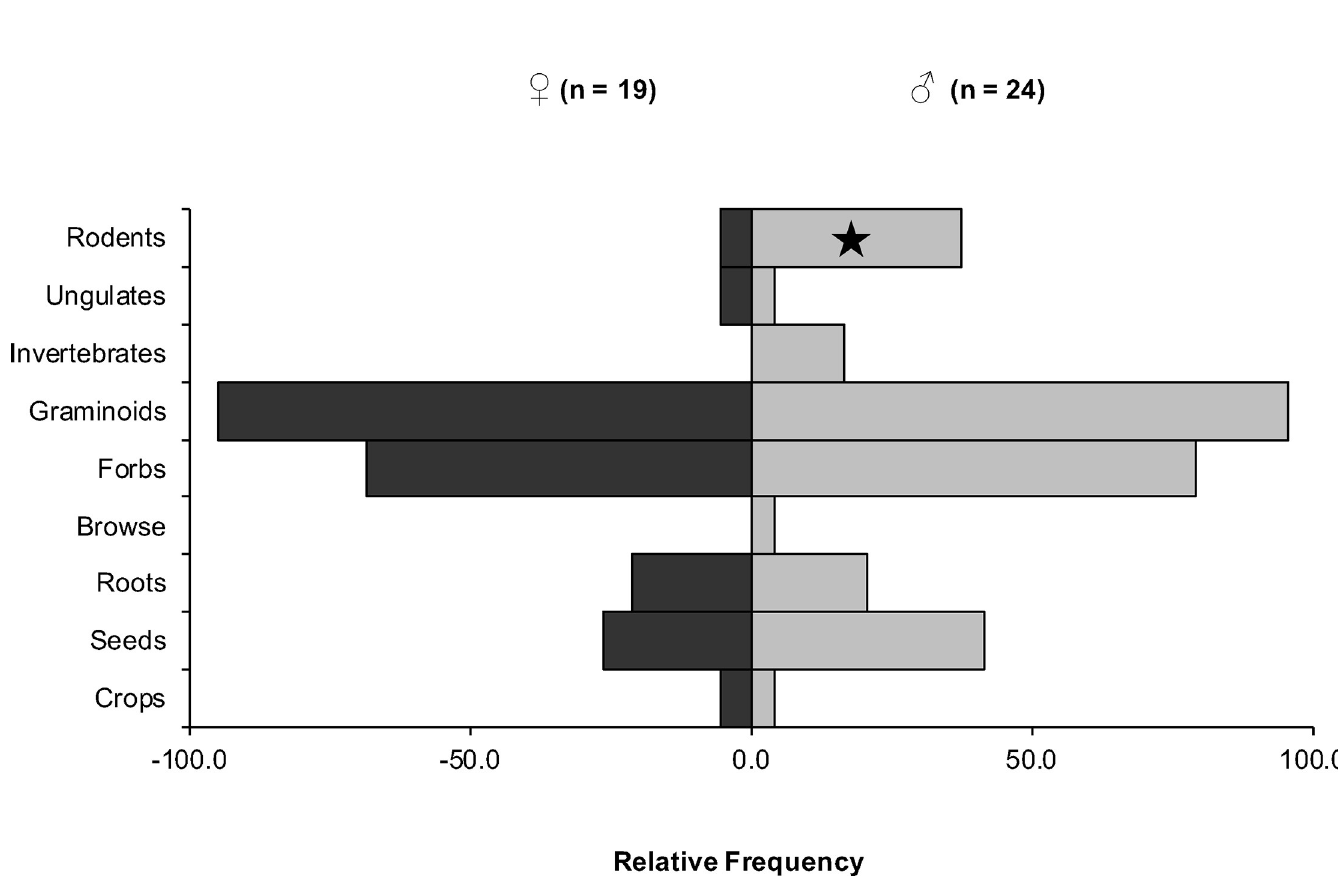
Fig 2. Sex differences in the diet of brown bears in Deosai National Park, Pakistan, based on scat analysis. Star indicates significant difference.